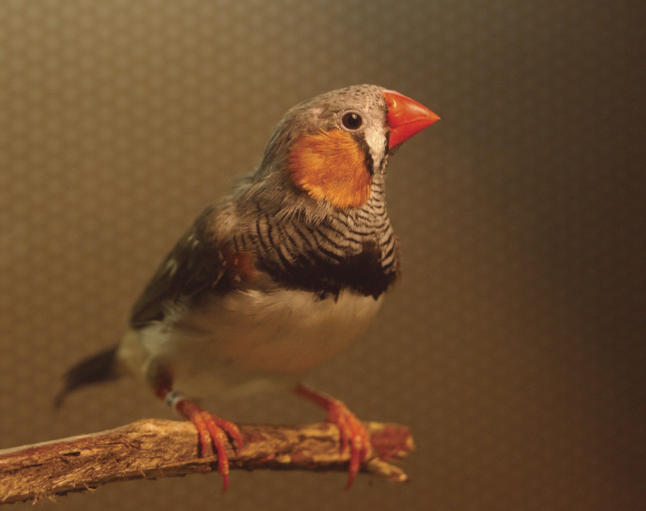
The vocal explorations of young zebra finches shed light on the neural basis of learning motor tasks (Photo: Daniel D. Baleckaitis)